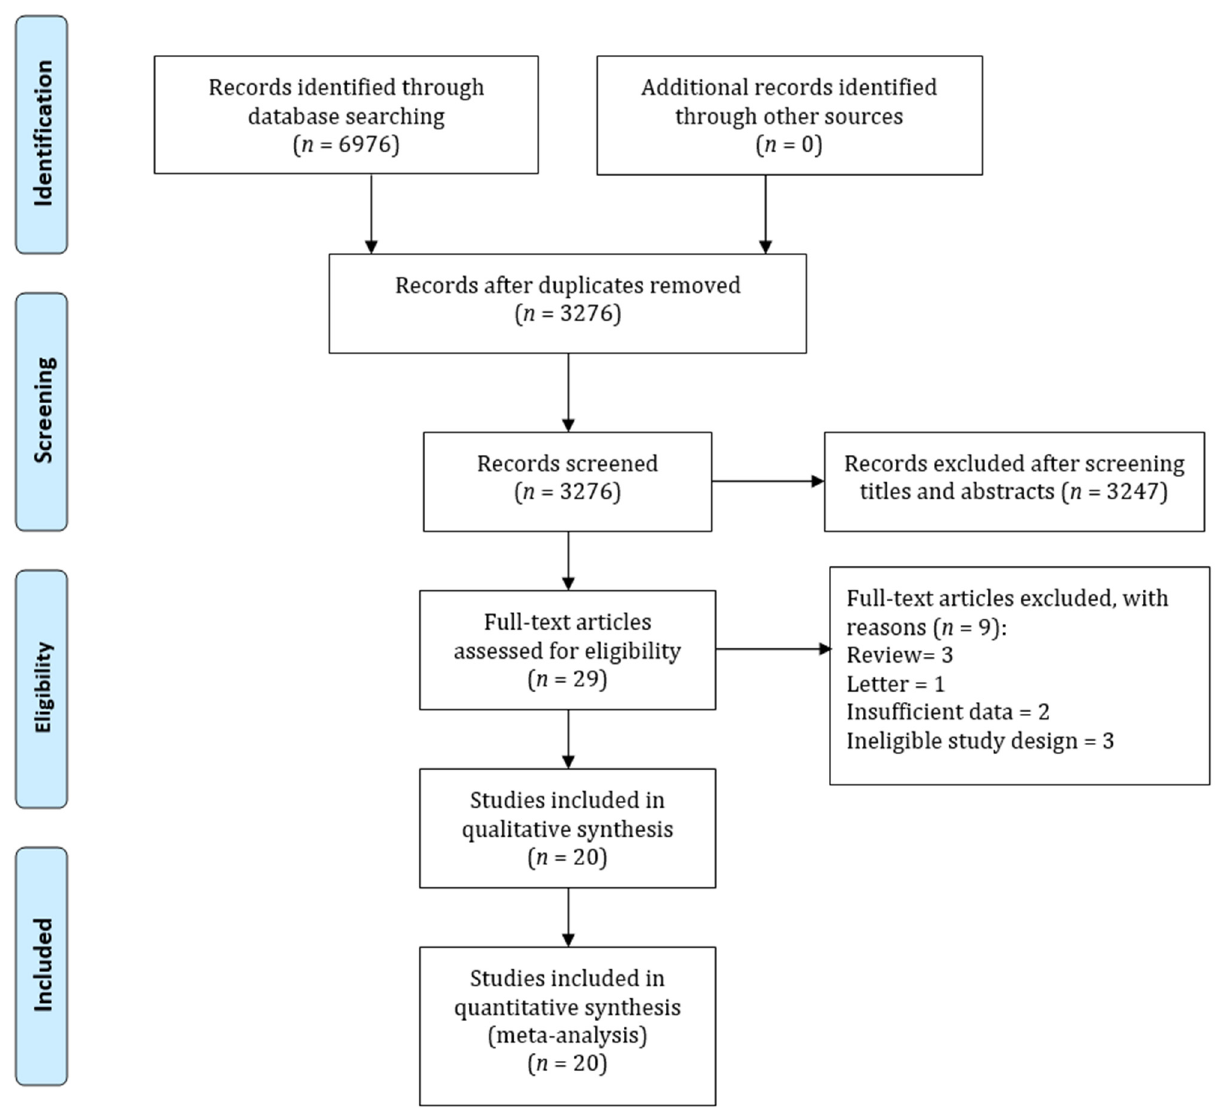
Figure 1. PRISMA flowchart for summarizing study identification and selection.